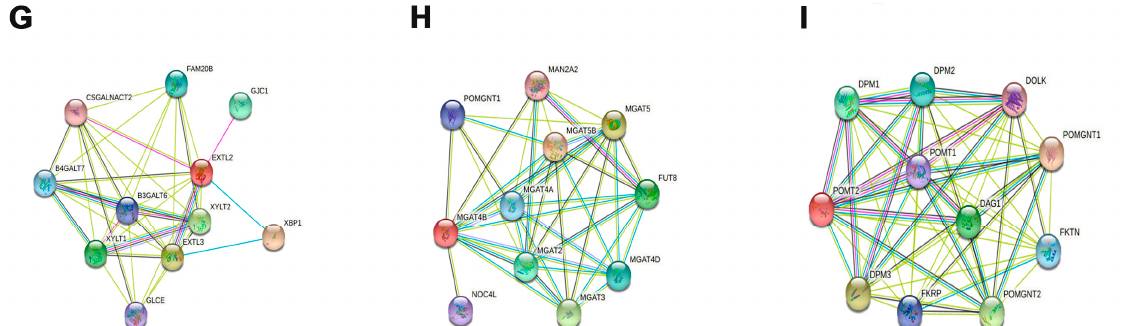
Figure 5. The functional analysis of four cuproptosis-related glycosyltransferases is shown. GO ( A ) and KEGG ( B ) functional enrichment analyses were performed for differentially expressed genes in the high and low-risk groups. The waterfall plot shows the frequency of mutations in the low-risk group ( C ) and the high-risk group ( D ). Difference analysis of the immune function between the high and low-risk groups ( E ). Prediction of the interacting proteins for cuproptosis-related